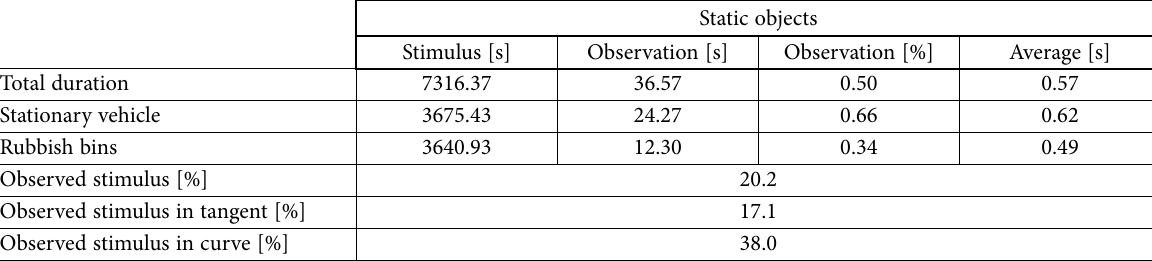
Table 3. Characteristics of the driver’s glance about the static objects during the travel